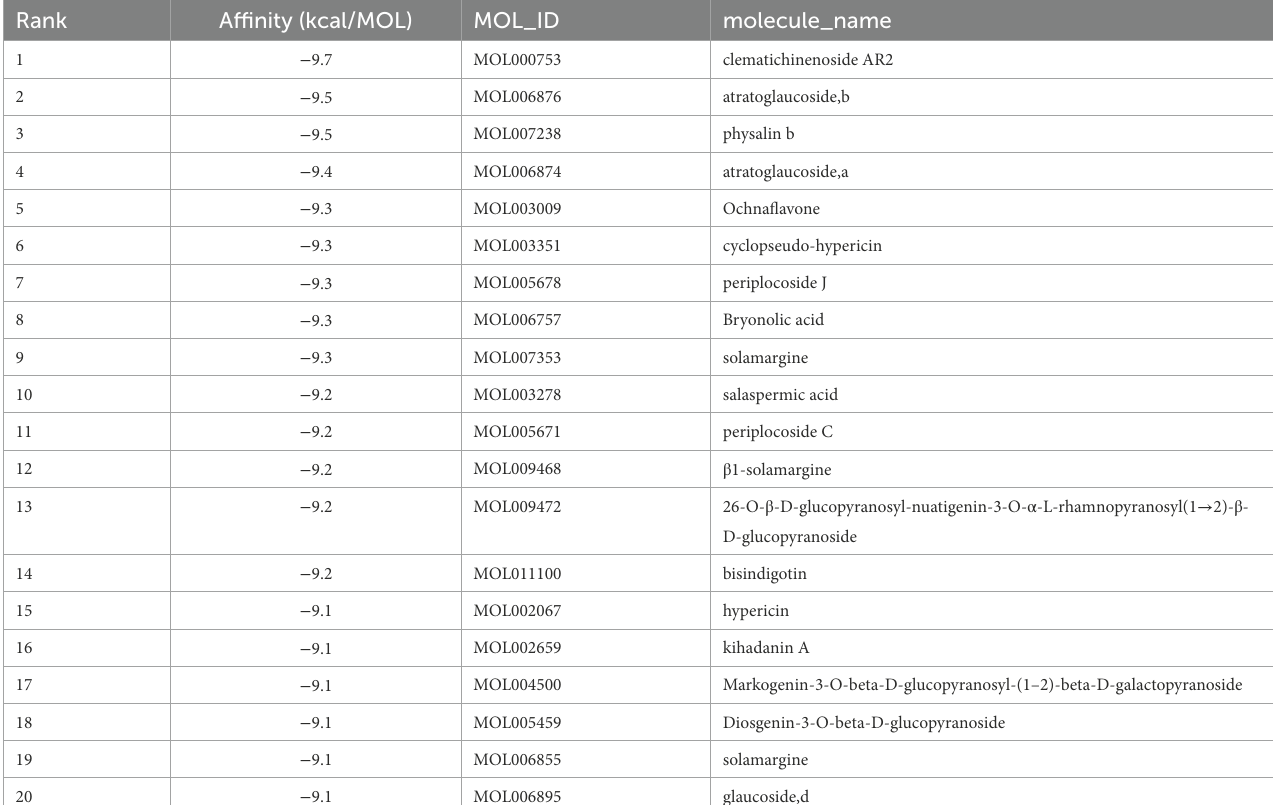
TABLE 1 Molecular docking results of Lambda S-CTD and compounds (top 20). Rank